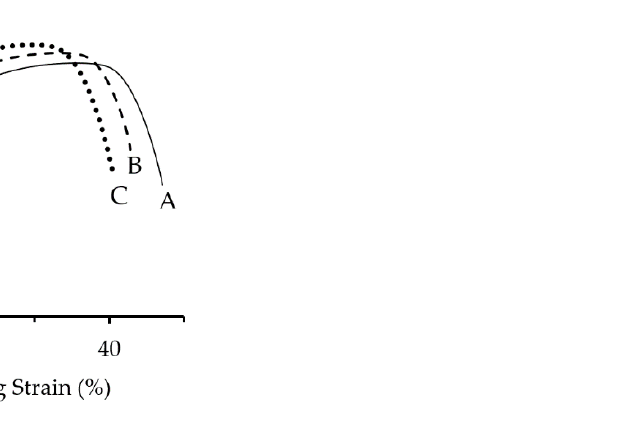
Figure 6. Engineering stress-strain curves for room-temperature tensile testing of the stabilized samples indicated. Each curve is labelled with the sample designation (Table 2).